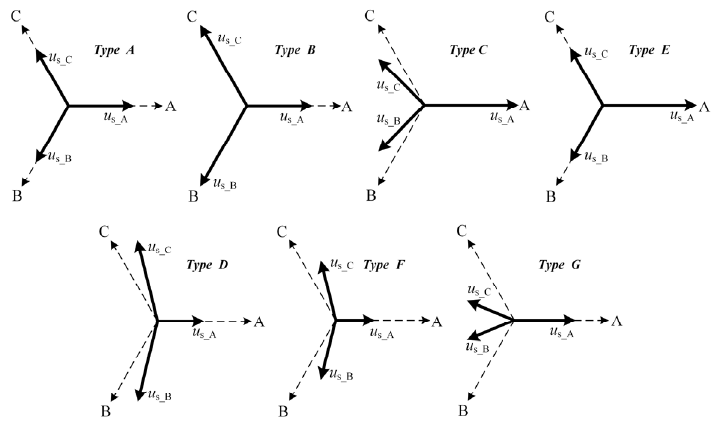
Figure 2. The seven basic voltage sag types of the distribution network.